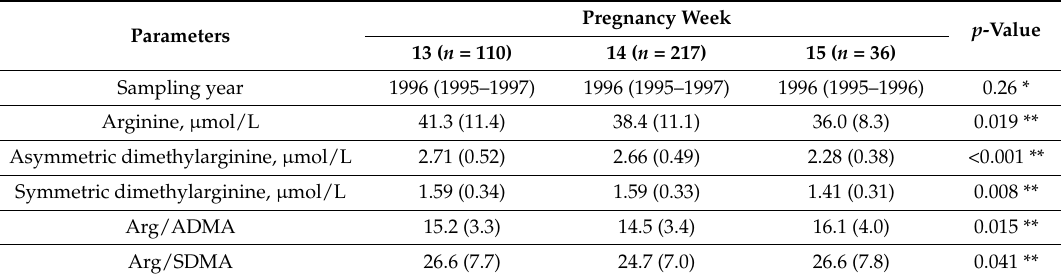
Concentrations of arginine, asymmetric dimethylarginine (ADMA), and symmetric dimethylarginine (SDMA) in amniotic fluid ( n = 363) according to the pregnancy